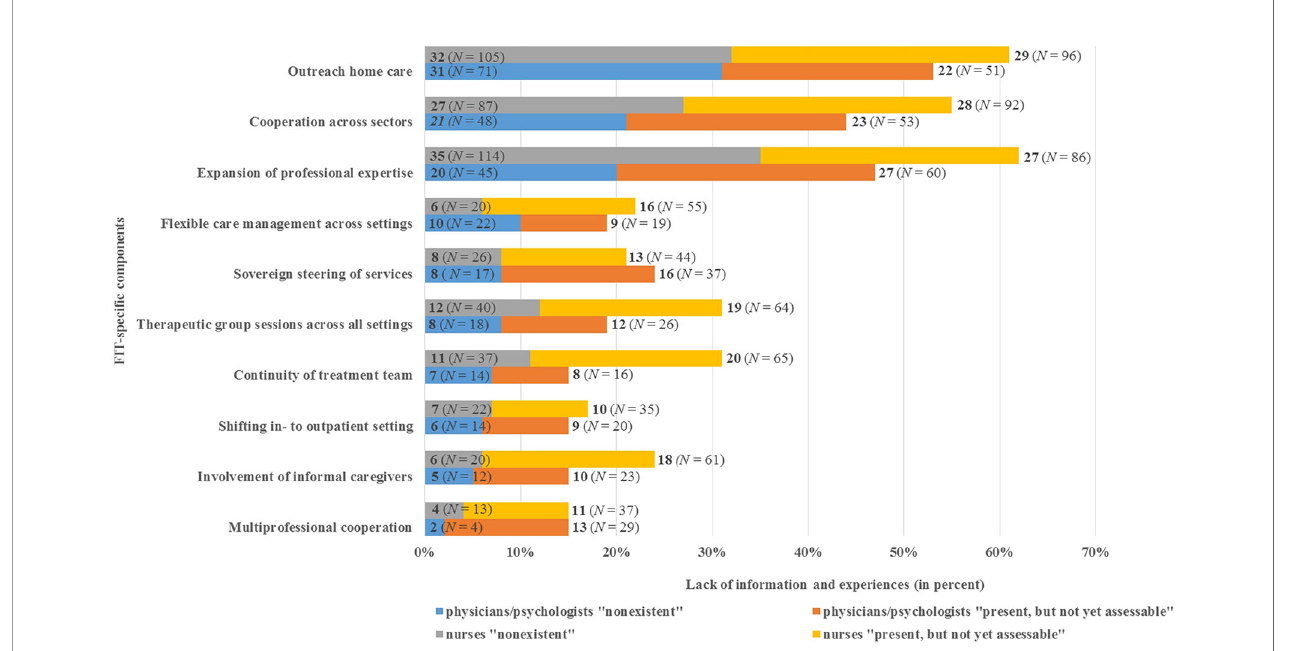
FIGURE 1 | Physicians ’ /psychologists ’ ( N = 211) and nurses ’ ( N = 352) lack of information and experience with FIT-speci fi c components